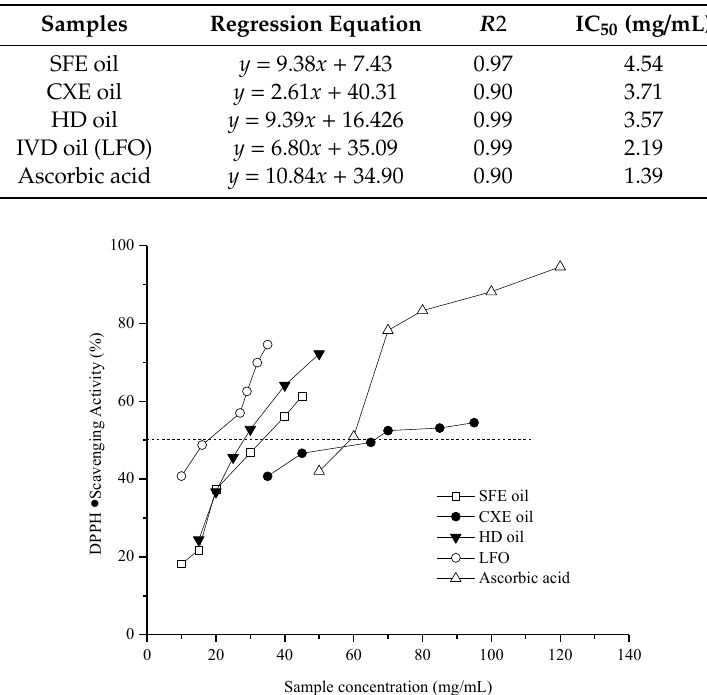
Figure 1. DPPH free radical scavenging ability of di ff erent samples of oil extracted from Vetiveria zizanioides root.